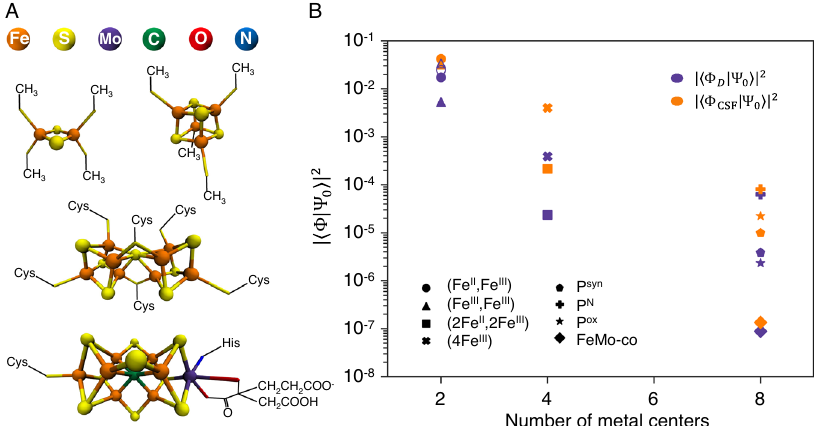
different oxidation states of the metal ions in the P-cluster. Both types of ansatz stateshowanexponentialdecreaseinweightwiththenumberofmetalcenters.For the [2Fe-2S]clusters, we also show resultsfor thelargestweightdeterminant using natural orbitals (empty symbols).